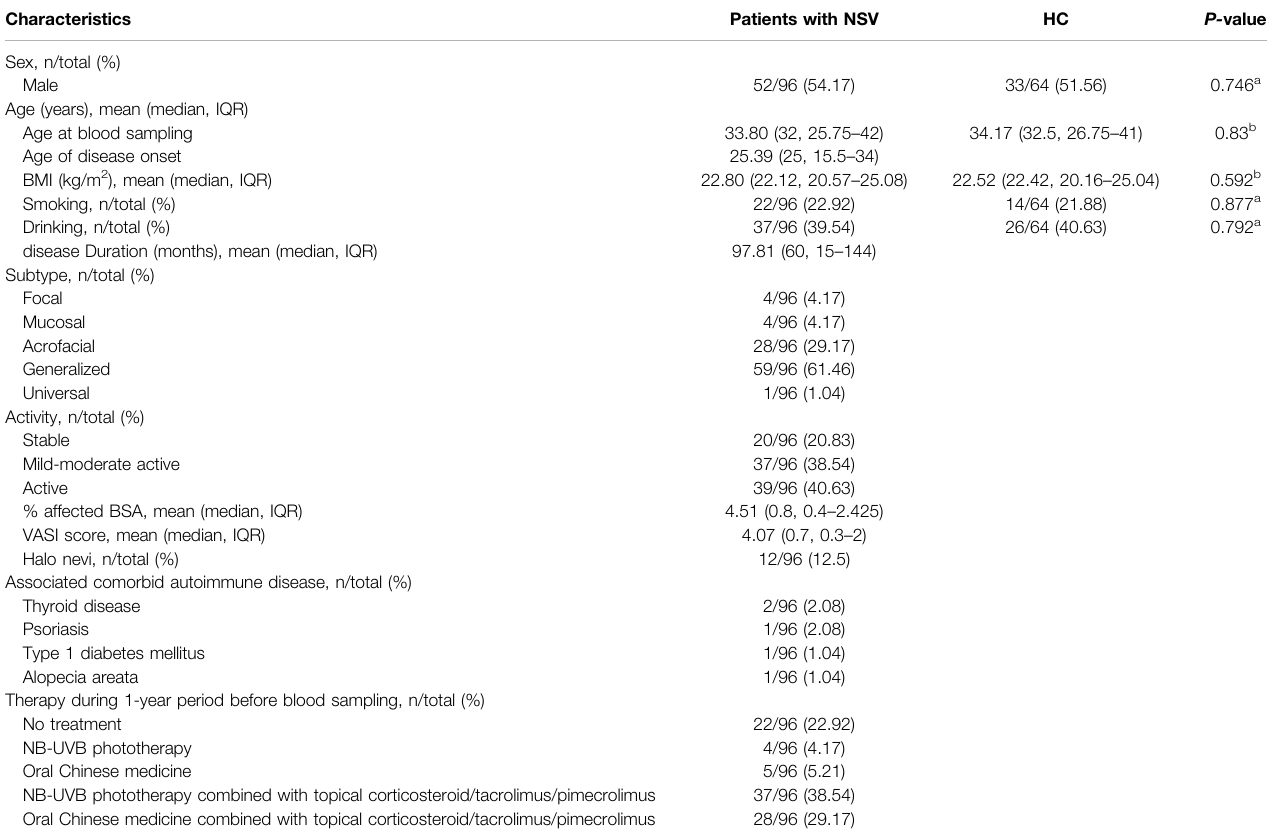
TABLE 1 | Characteristics of patients with NSV and HC included in this study.